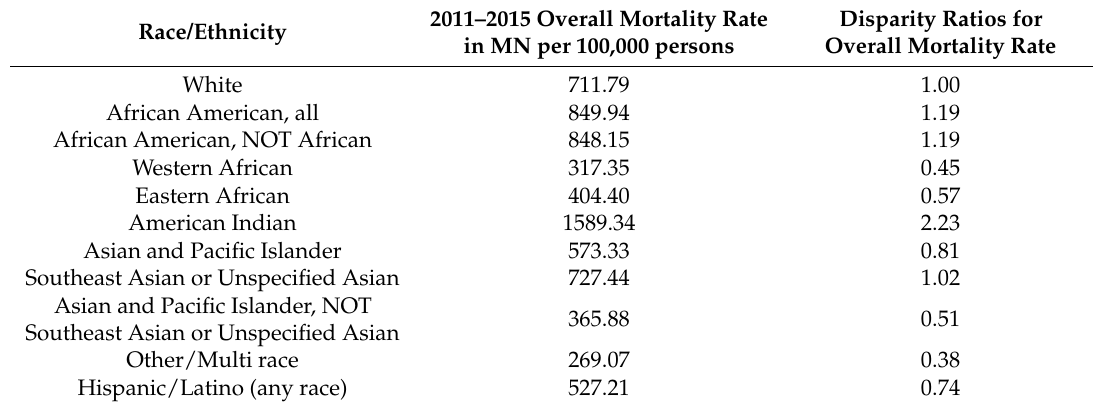
Table 1. Age-adjusted overall mortality rate by race/ethnicity, in Minnesota (MN), 2011–2015. 2011–2015 Overall Mortality Rate Race/Ethnicity in MN per 100,000 persons